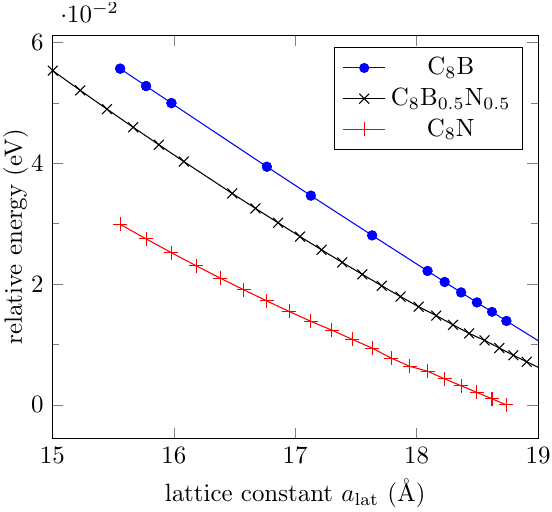
Figure 9. Energy evolution of relaxed GO layers when all oxygen atoms are replaced by boron (blue marks) or nitrogen (red marks) atoms or a pair B-N (black marks), according to DFT calculations.